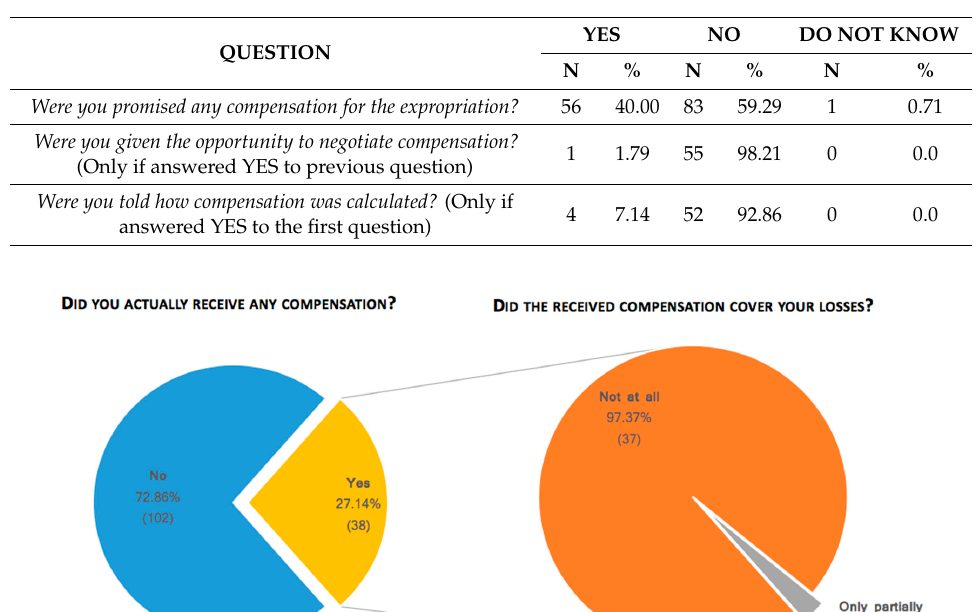
Table 8. Promised Compensation.